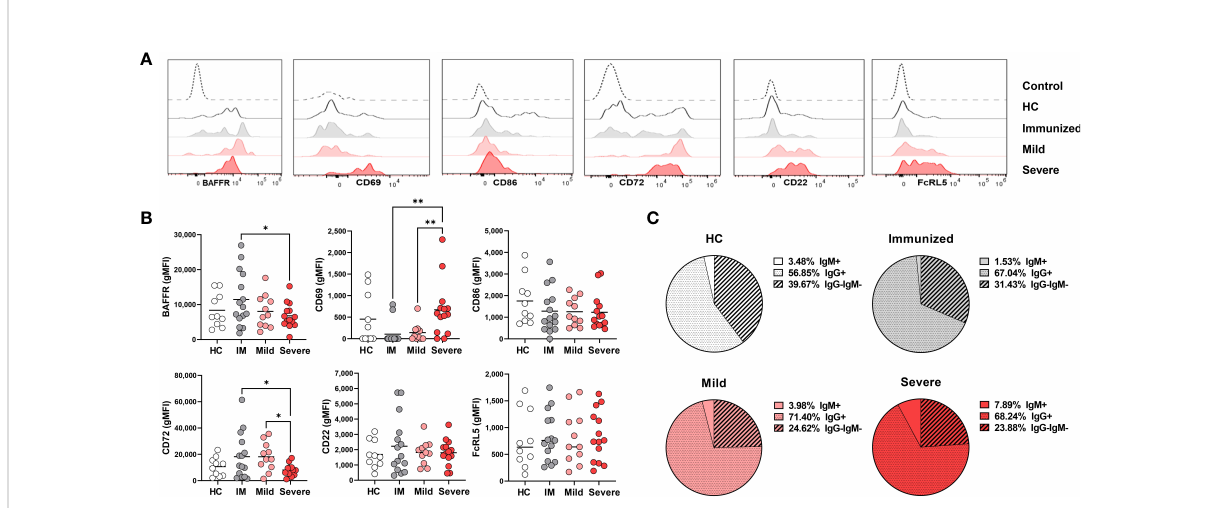
FIGURE 4 Phenotypic changes in DN2 cells with Severe SARS-CoV-2 infection. (A) Representative histograms depicting expression of BAFFR, CD69, CD86, CD72, CD22 and FcRL5 on DN2 cells from a healthy control (HC), individual immunized against SARS-CoV-2 or individuals with mild or severe SARS-CoV-2 infection. Control dotted histogram is an FMO for CD69, CD68, CD72 and CD22. Control dotted histogram for BAFFR and FcRL5 is expression on CD3+ T cells from a healthy control subject. (B) Quanti fi cation of BAFFR, CD69, CD86, CD72, CD22 and FcRL5 expression (gMFI: geometric mean fl uorescent intensity) on DN2 cells from healthy controls (HC), those immunized against SARS-CoV-2 (IM), or individuals with mild or severe SARS-CoV-2 infection. (C) Pie charts depicting the average frequency of IgM+, IgG+, or IgG-IgM- DN2 cells for healthy controls (HC, N=10), individuals immunized against SARS-CoV-2 (N=15), and individuals with mild (N=11) or severe SARS-CoV-2 infection (N=14). Statistics: one-way ANOVA, *p < 0.05, **p <